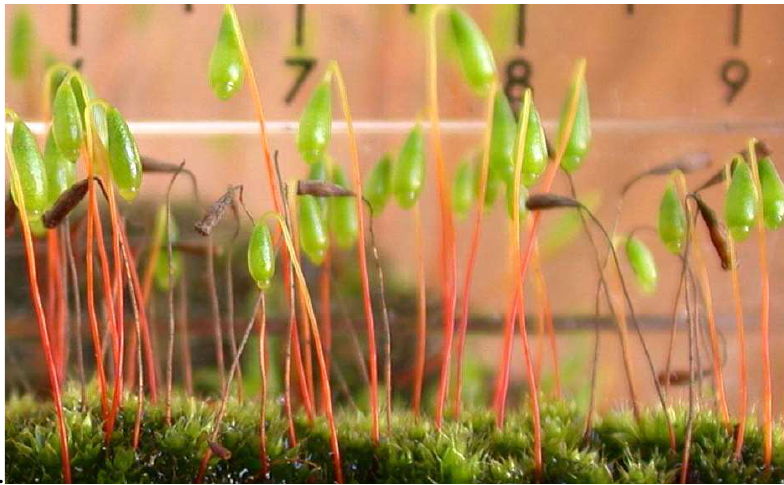
Figure 11. The moss Bryum capillare exemplifies the alternation of generations. Bryum capillare with attached diploid sporophytes dependent on the haploid gametophyte generation. (Photo: DTAL).